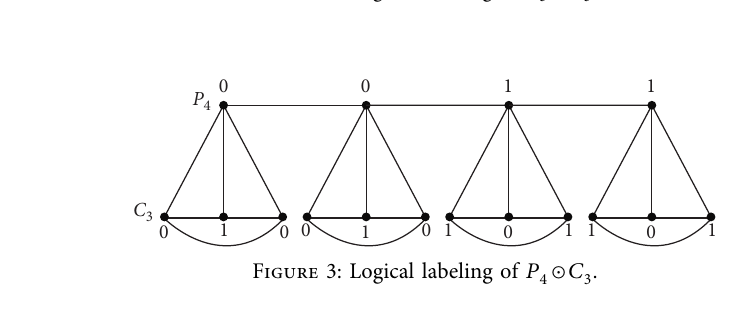
Figure 2: Logical labeling of P